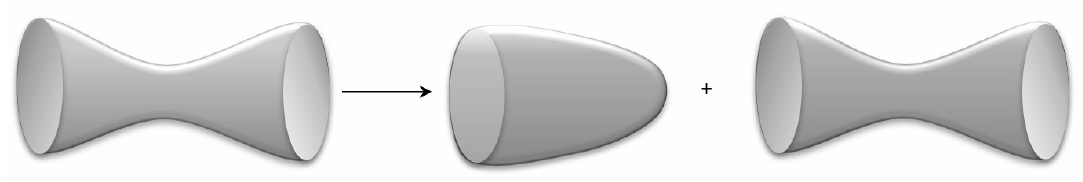
Figure 41 . Schematic representation of flow-fragmentation and the generation of an extra